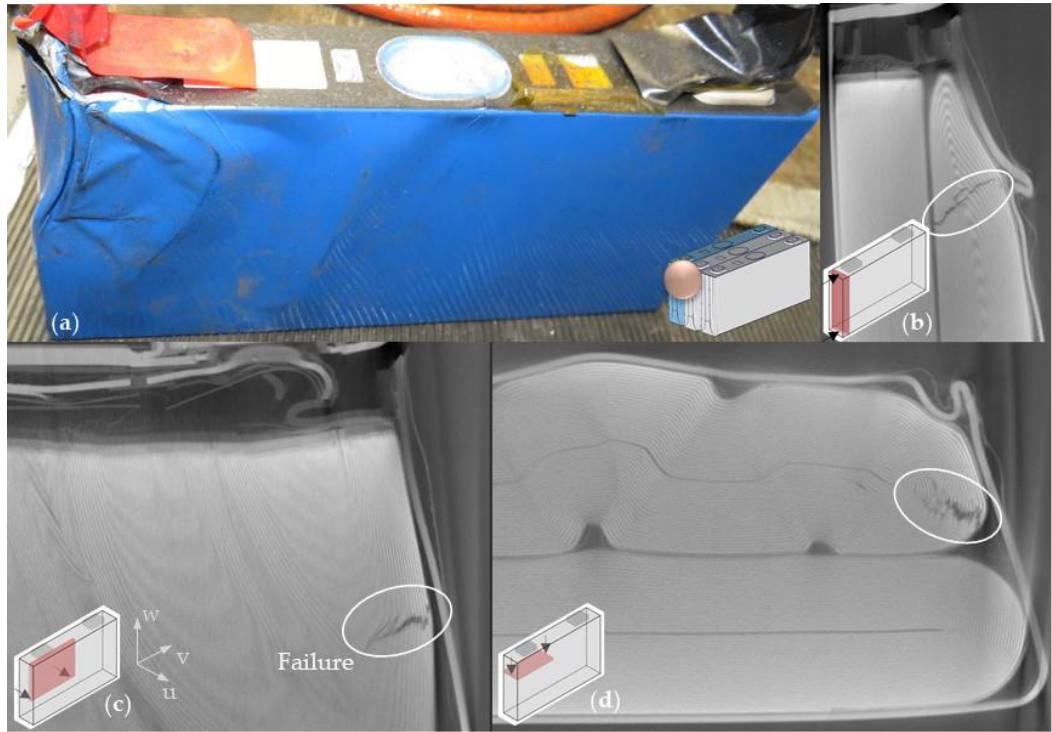
Figure 14. V-direction with hemispherical impactor: ( a ) deformed left cell; ( b – d ) CT-Scans.